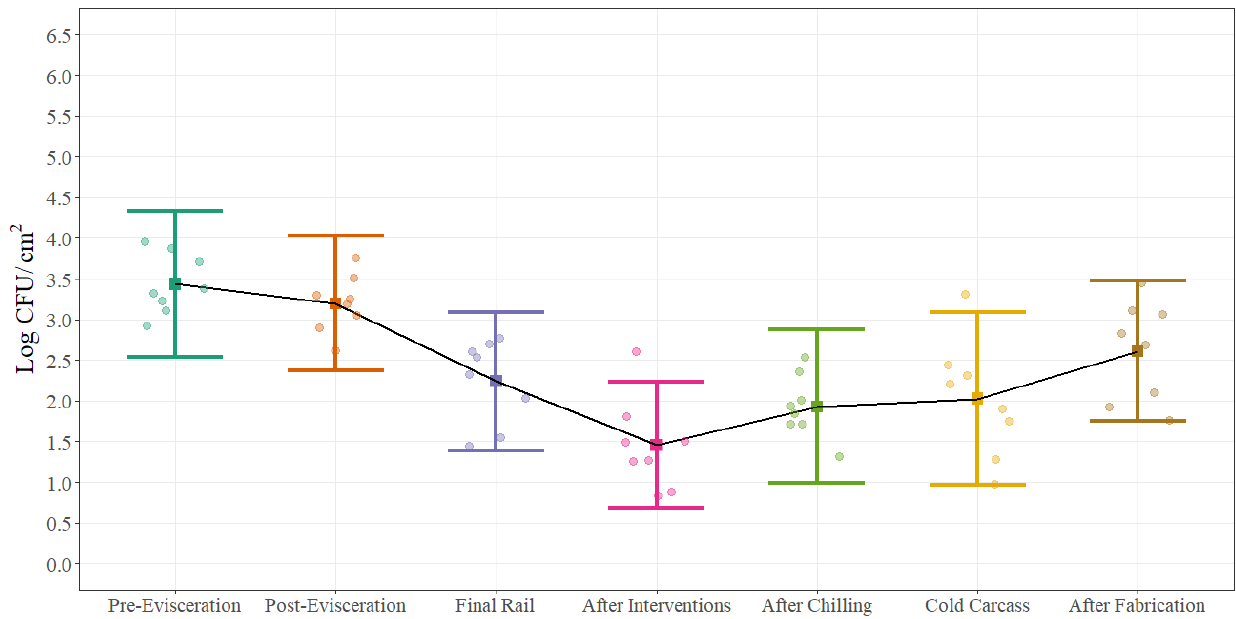
Figure 4. Statistical microbial process control for Aerobic Plate Counts (Log CFU/cm 2 ) at different sampling locations on the beef processing line. Solid squares represent the mean of each sampling point for all carcass regions and error bars represent ±3 standard deviations around the mean using a sample size of 12 swabs collected during 8 different sampling days. The black solid line represents the change on the average of each sampling point throughout the beef processing line. The points represent the actual data points.